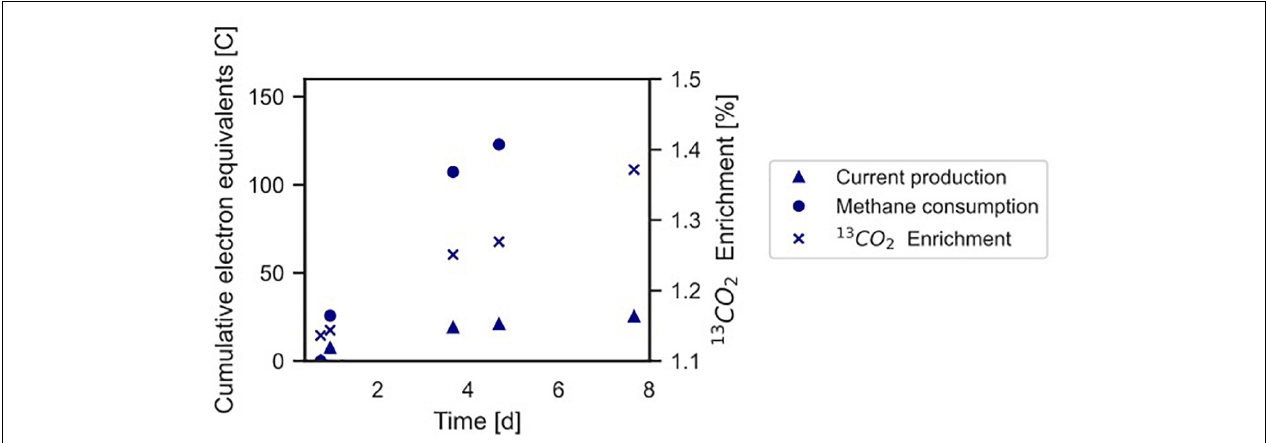
FIGURE 4 | Conversion of 13 CH 4 to 13 CO 2 by the microbial community in the BES indicating anaerobic methanotrophy. The Coulombic efficiency in this experiment was calculated to be 17.3%. Profiles of methane and current are expressed as cumulative electron equivalents at the primary y-axis, 13 CO 2 enrichment (% 13 CO 2 /Total CO 2 ) is shown at the secondary y-axis. The graph refers to experiment A. The area of the electrode is 0.0018 m 2 . • , methane consumption; (cid:49) current production; x 13 CO 2